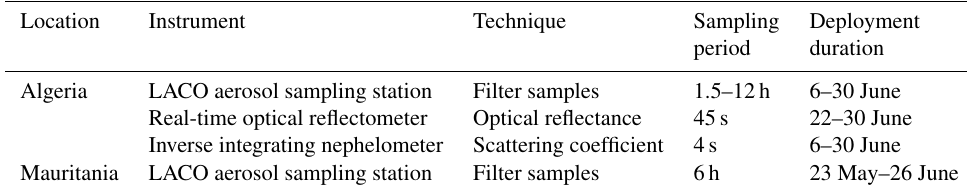
Table 1. Characteristics and sampling period of the LACO–UMBC instruments deployed during the Fennec campaign. Location